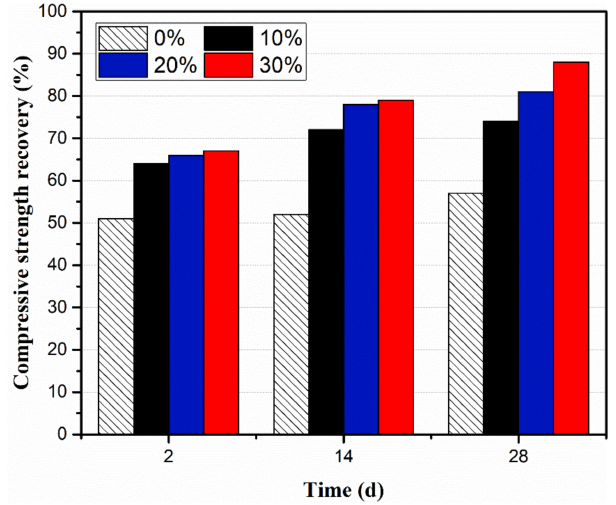
Figure 6. Compressive strength recovery at di ff erent curing